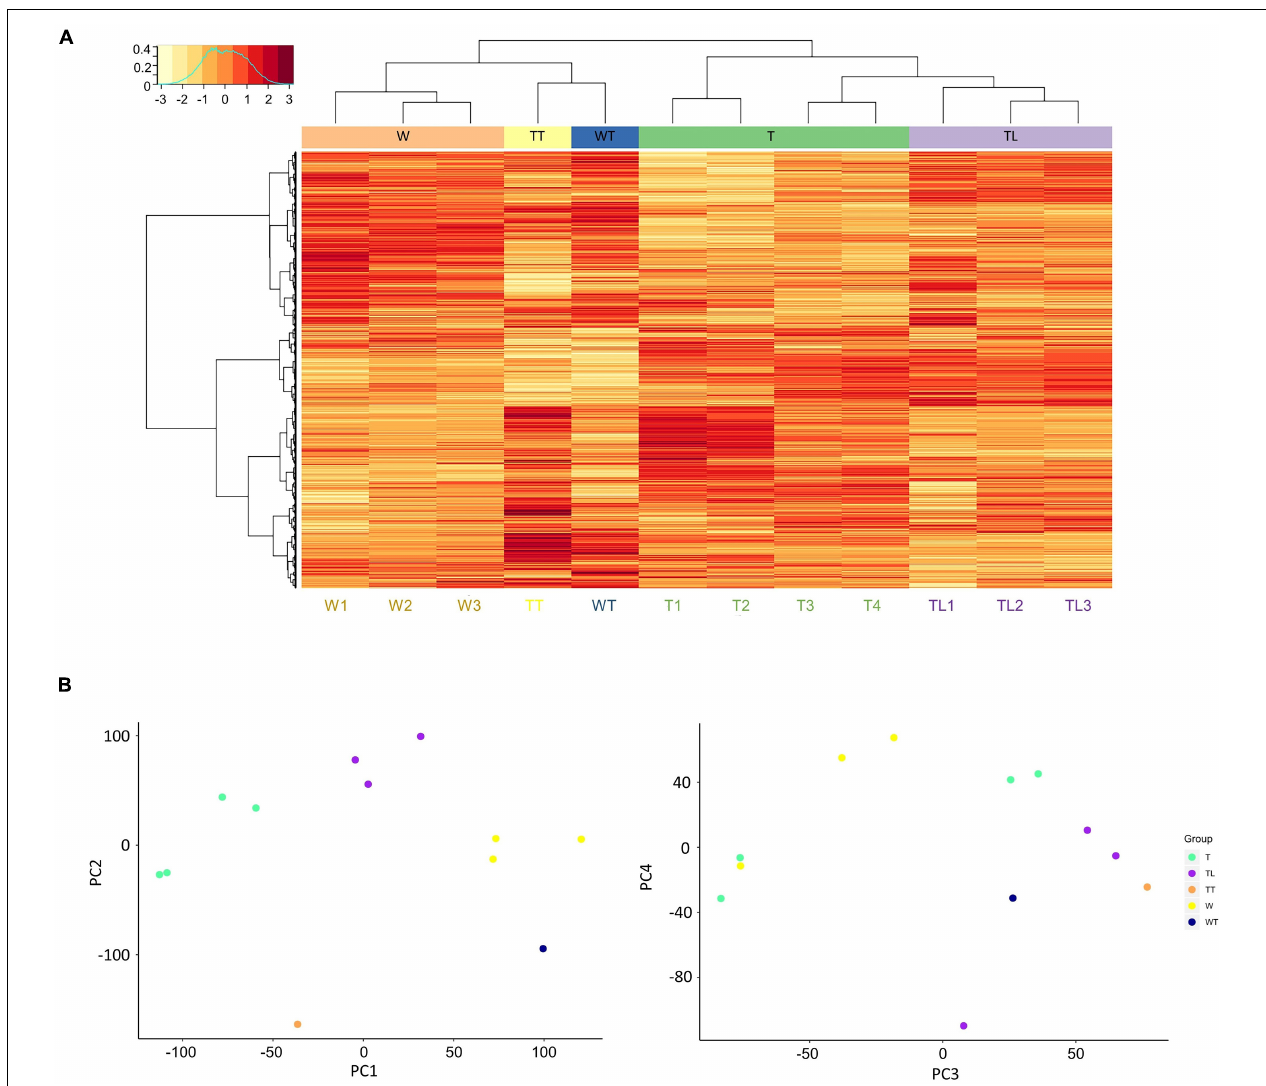
FIGURE 2 | Clustering of the transcriptomes. (A) Hierarchical clustering and gene expression heatmap. In the heat map, each row represents a gene, and each column represents a transcriptome. The clustering trees based on transcriptomes and genes are shown on the top and to the left of the heat map. In the left top legend, the horizontal axis denotes the normalized expression values of genes, and the vertical axis shows the normalized frequency of genes at the different expression levels. (B) Distribution of samples along PC1 to 4 from the principal component